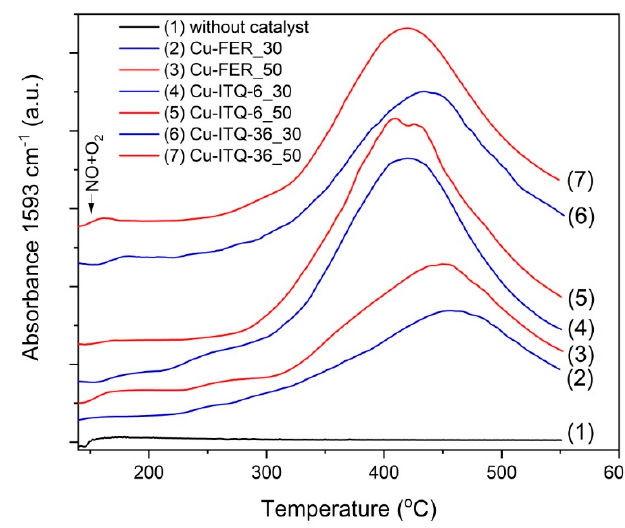
Figure 8. Results of NO to NO 2 oxidation for FER, ITQ-6 and ITQ-36 samples modified with Cu.